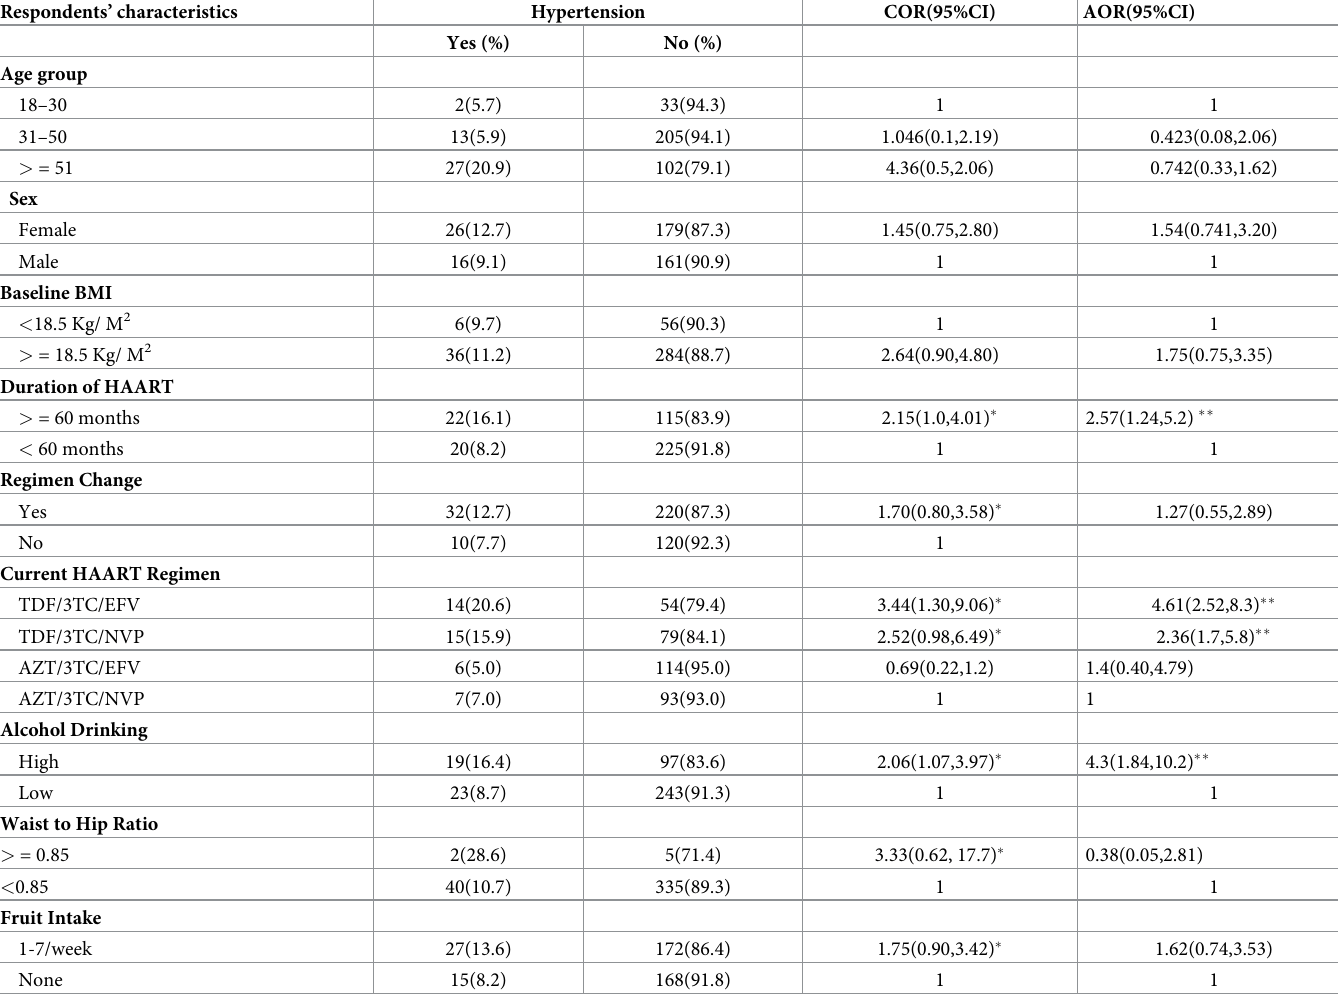
Table 5. Bivariable and multivariable logistic regression analysis of factors associated with hypertension among clients receiving HAART at NEMMRH from Janu- ary 20-March 20,